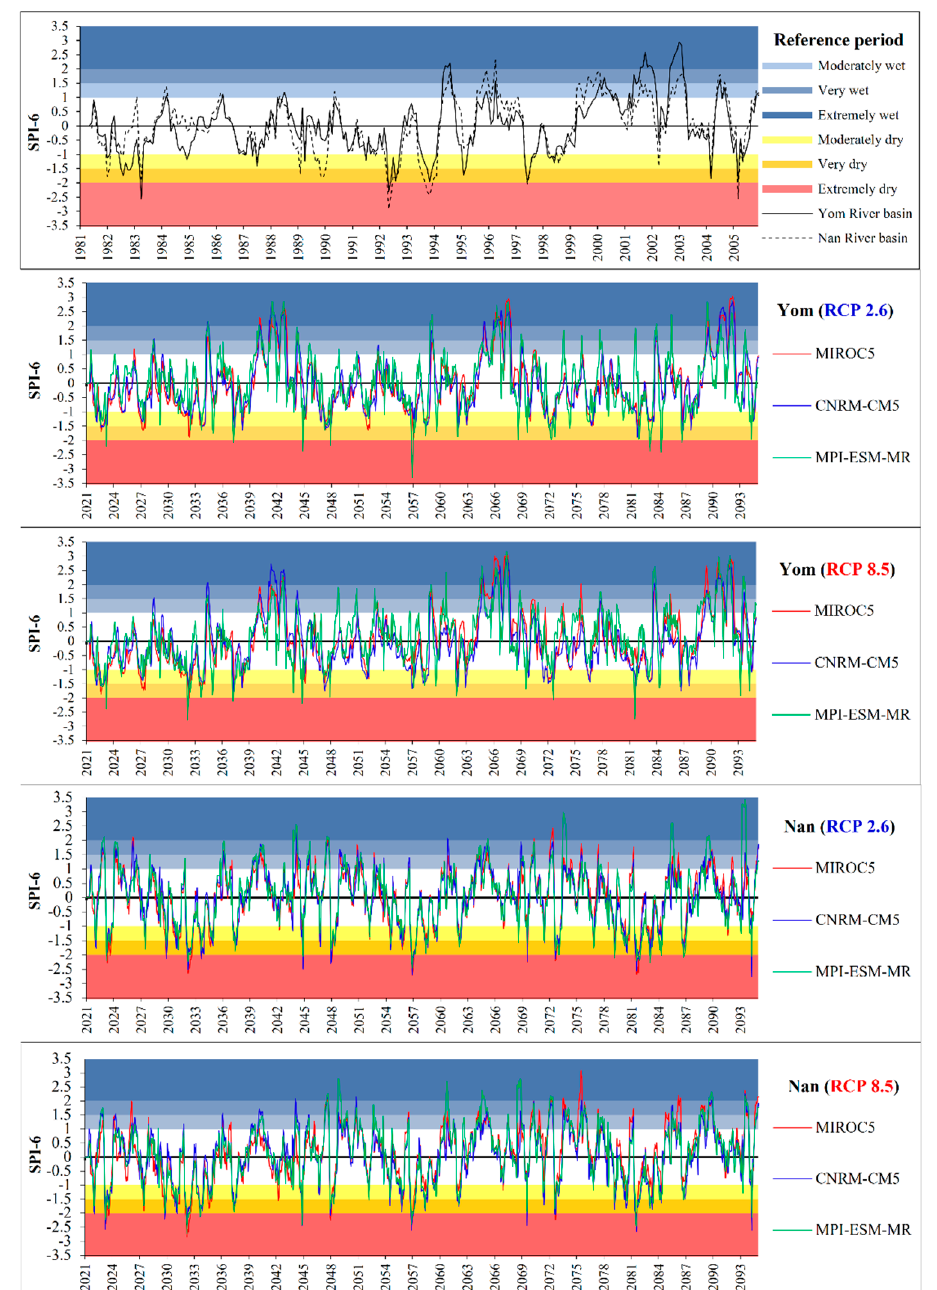
Figure 15. Standardized Precipitation Index of 6-month rainfall duration in the Yom and Nan River basins in the reference period with future periods under scenarios RCP 2.6 and RCP 8.5.